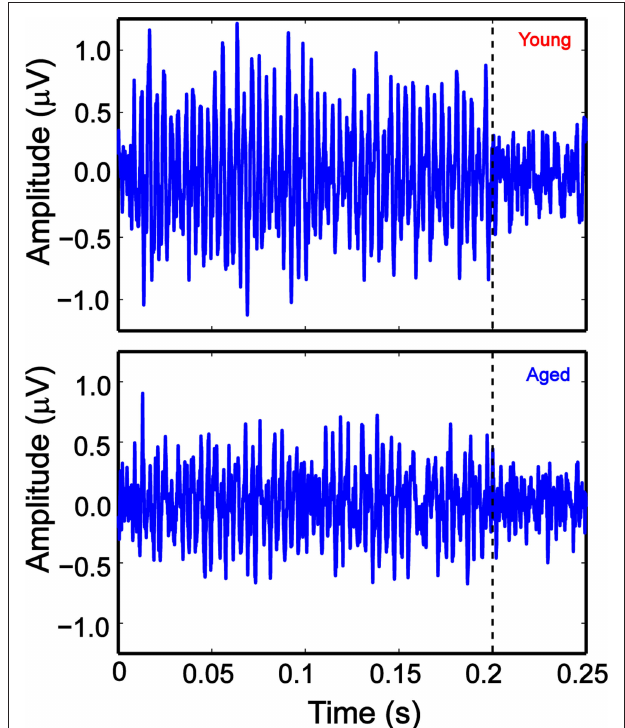
Figure 1 | example AMFr traces of young (top panel) and aged (bottom panel) animals, at 256 Hz AM, 100% modulation depth and 75 dB SPL, showing clear phase locking to the AM envelope of the stimulus. The stimulus was 200-ms long, and the recording window was 300 ms. The dotted lines indicate stimulus offset. The x axis shows the time of acquisition and the y axis shows the amplitude of the AMFR